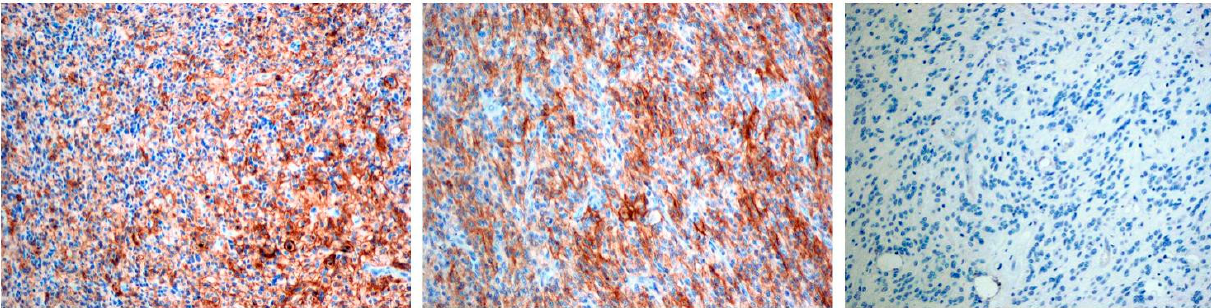
Figure 1. The first two pictures present positive PD-L1 immunostaining in pGBM cells, the last picture presents negative